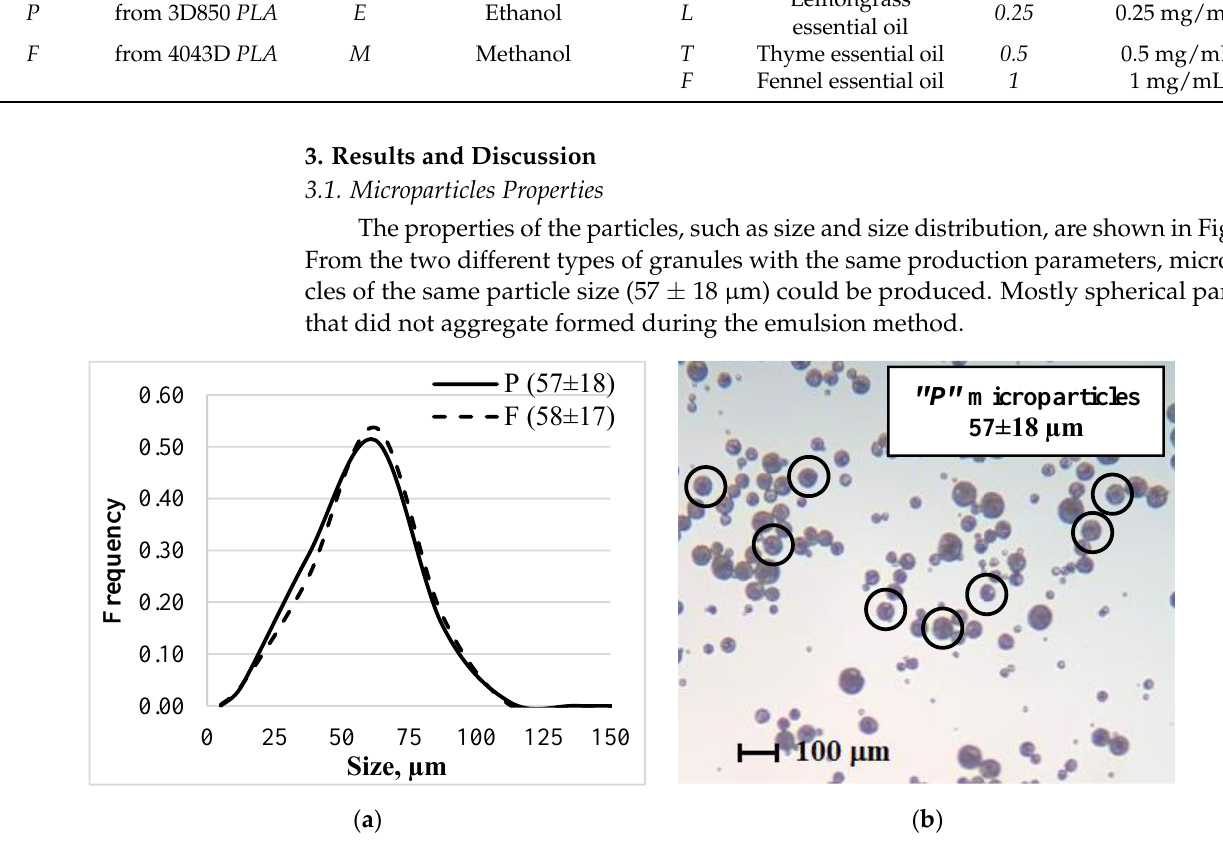
Figure 1. Microparticles properties: ( a ) Size distribution of the particles prepared with the single emulsion method; ( b ) Picture of the prepared microparticles.